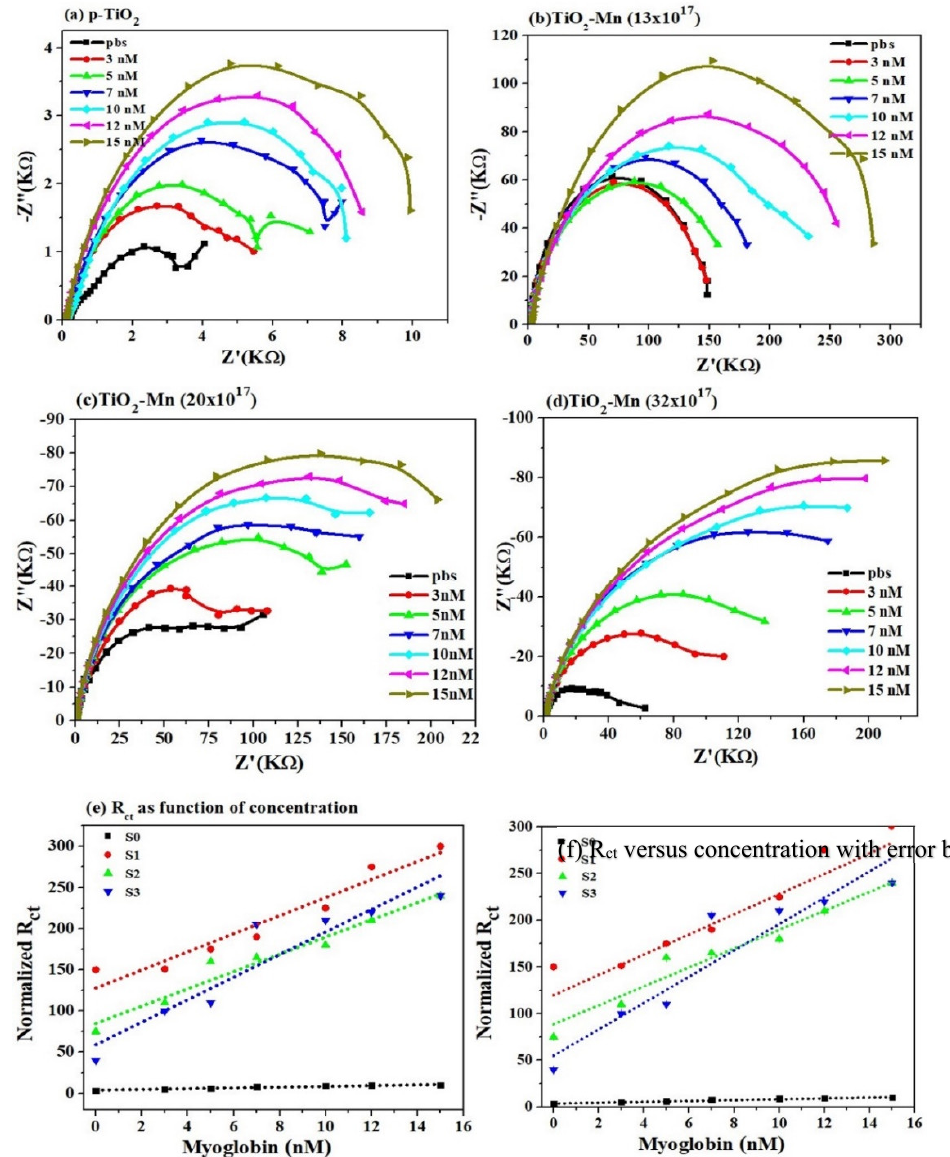
Figure 8. Series of Nyquist plots acquired for different Mb concentration for as synthesized TiO 2 and Mn-doped TiO 2 nanoparticles: ( a ) S0—pristine TiO 2 ( b ) S1—TiO 2 -Mn (13 × 10 17 ) ( c ) S2—TiO 2 -Mn (20 × 10 17 ); ( d ) S3—TiO 2 -Mn (32 × 10 17 ); ( e ) R ct values of Mb at 3–15 nM in PBS. ( f ) Error bar in R ct values estimated from three measured